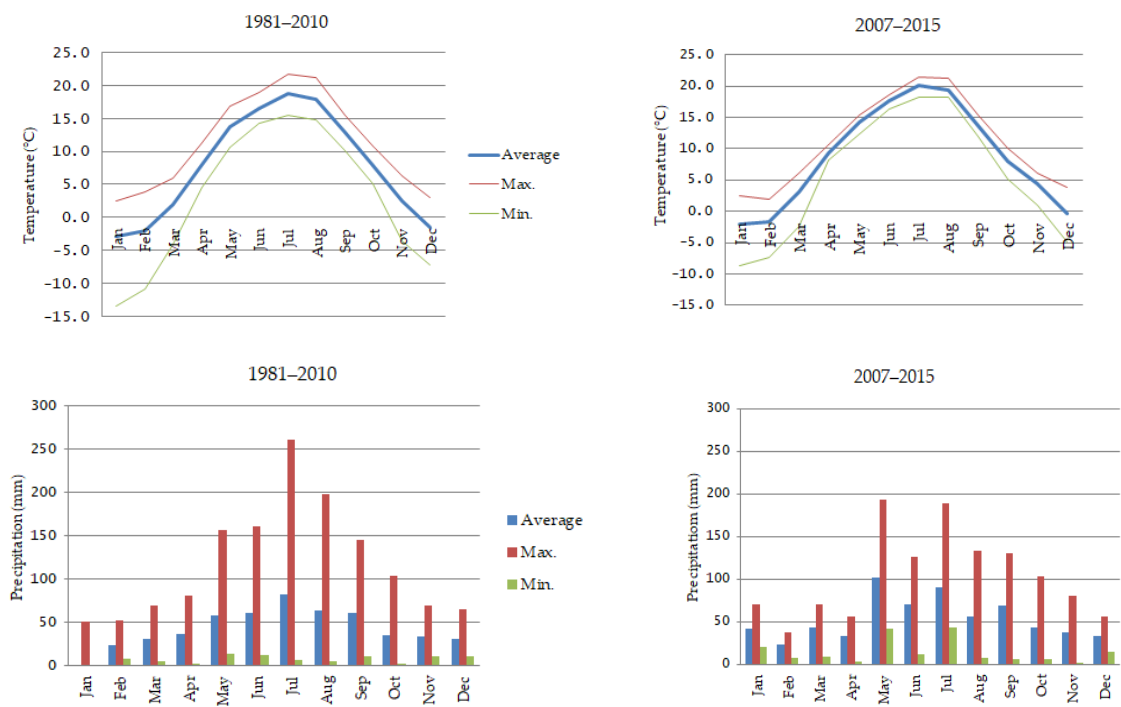
Figure 2. Monthly air temperature ( ◦ C) and precipitation (mm) from the Felin experimental station during the 2007–2015 study period in comparison with the 1981–2010 long-term